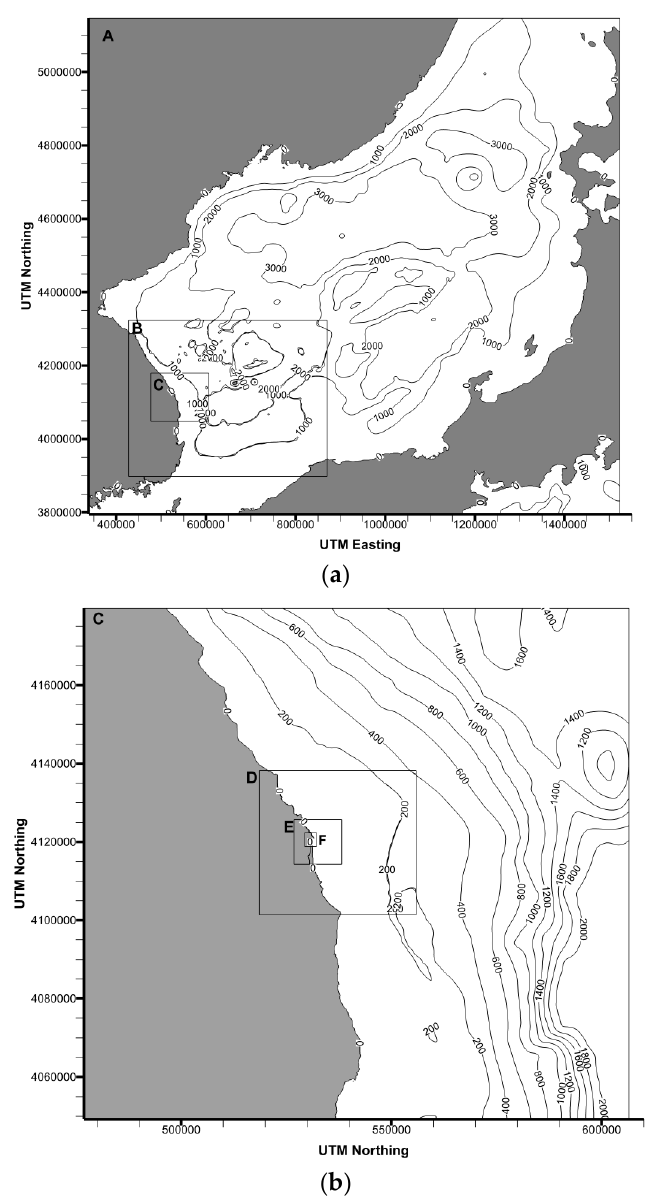
Figure 5. Nestled grid for Imwon Port, ( a ) regions A–C; ( b ) regions C–F. Table 3. Computational mesh details.